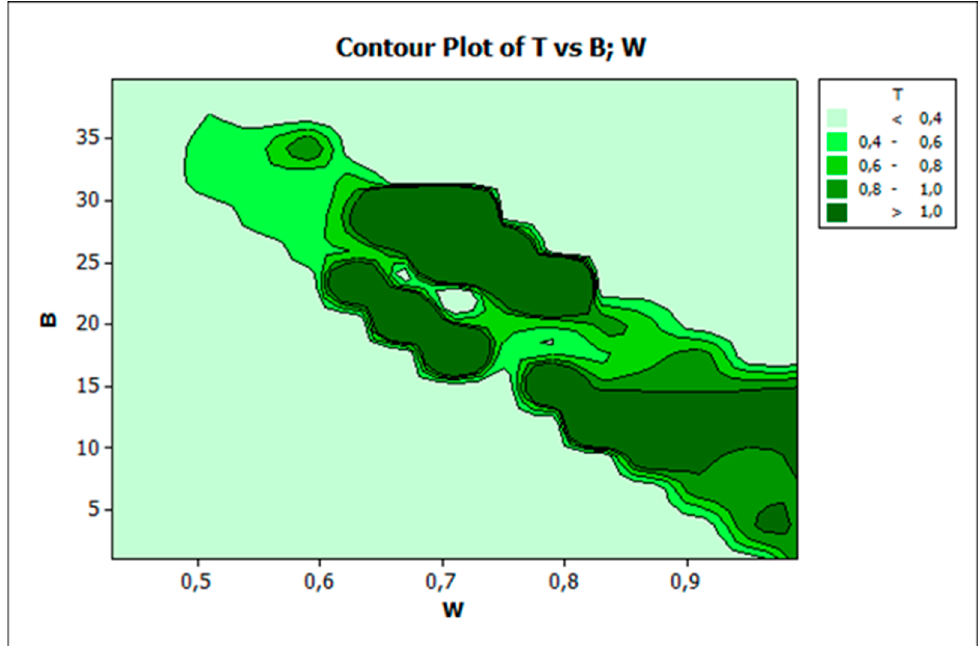
Figure 8. Interaction plot of the input parameters FP, ALCTV, PFCTV, SEQ for B.